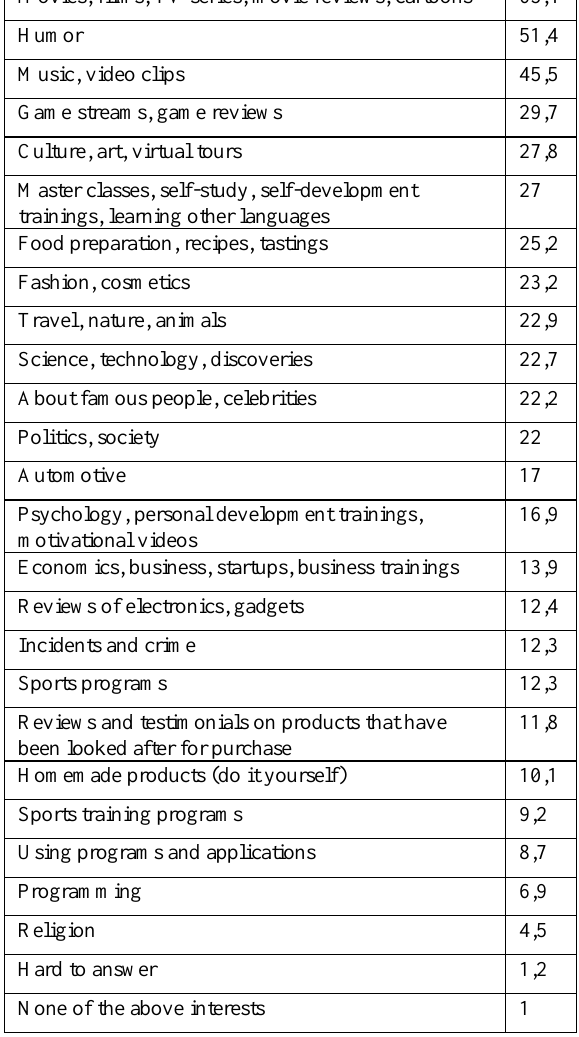
Table 1. Internet usage preferences, % Table 2. Interests in regular (at least 1 time per week)